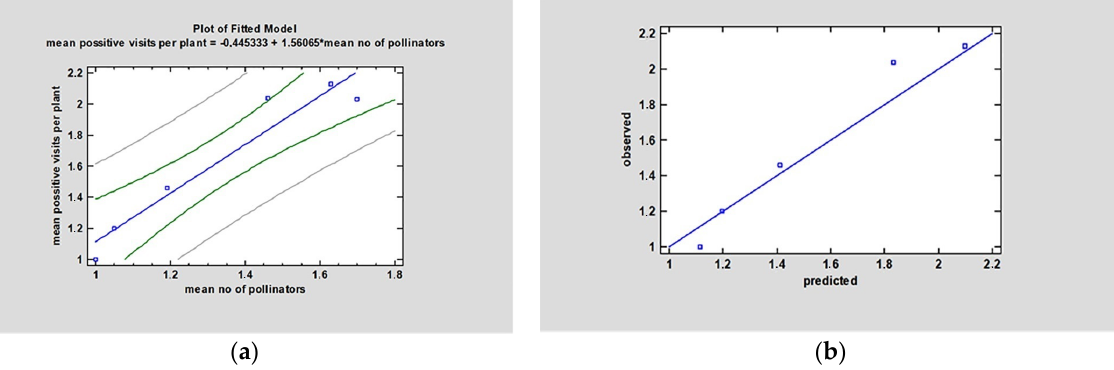
Figure 6. ( a ) Regression model of foraging behavior and pollinator abundance; ( b ) Predicted and observed values for the regression of foraging behavior on pollinator abundance.